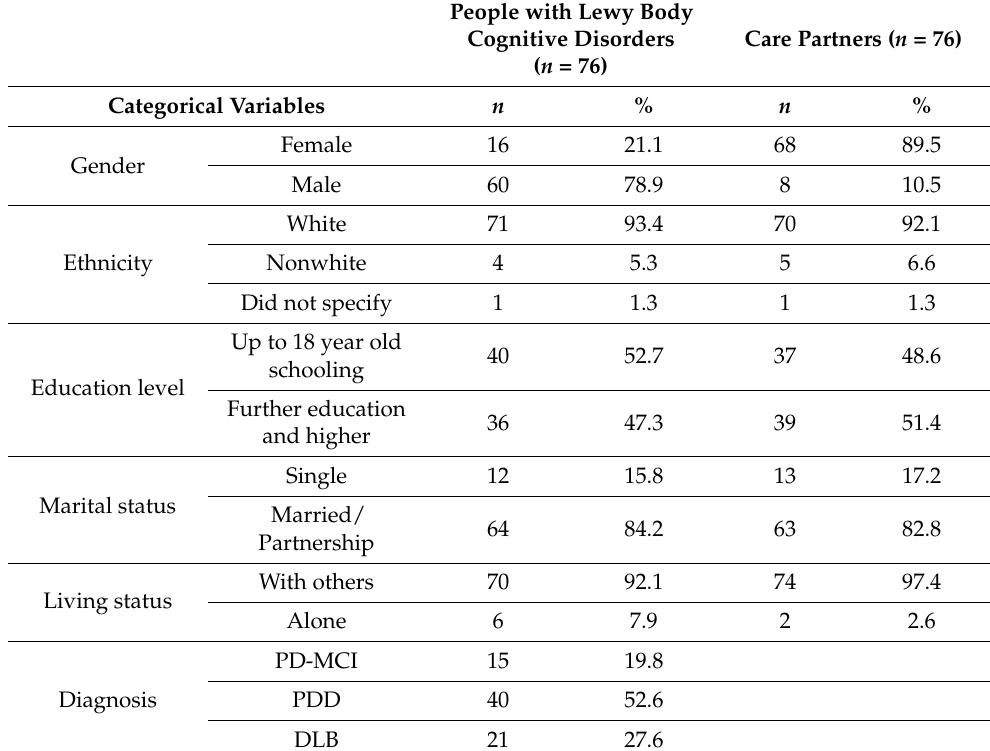
Table 2. Demographic and clinical variables of people with Lewy body-related cognitive disorders and care partners ( n = 76